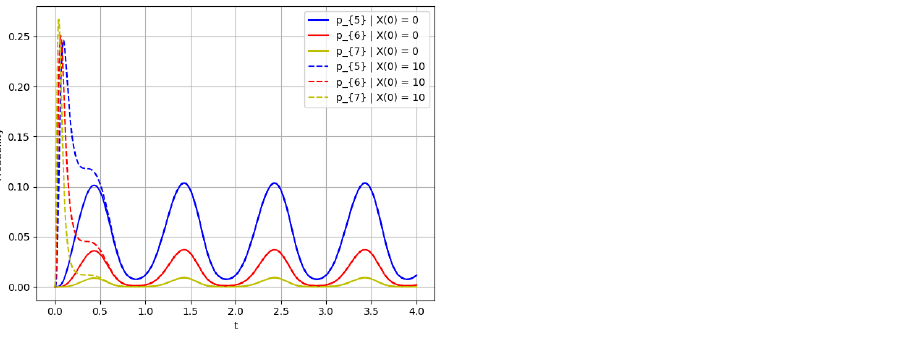
Figure 15. Probability p 5 ( t ) , p 6 ( t ) , p 7 ( t ) for t ∈ [ 0,4 ] ; this figure shows the rate of convergence for N =